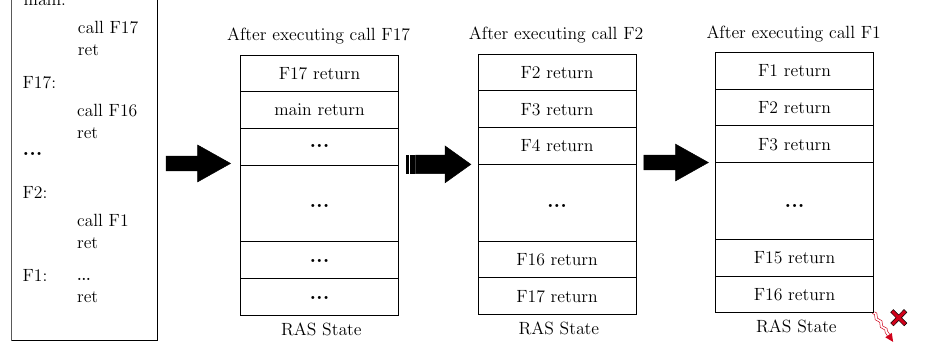
Figure 2: Reverse Engineering Return Address